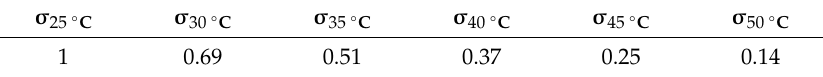
Table 1. Lead–acid battery lifetime correction factor dependent on the